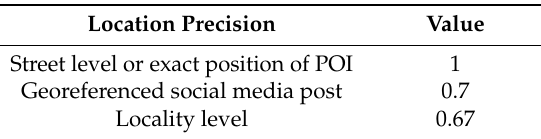
Table 1. Location precision coefficients.